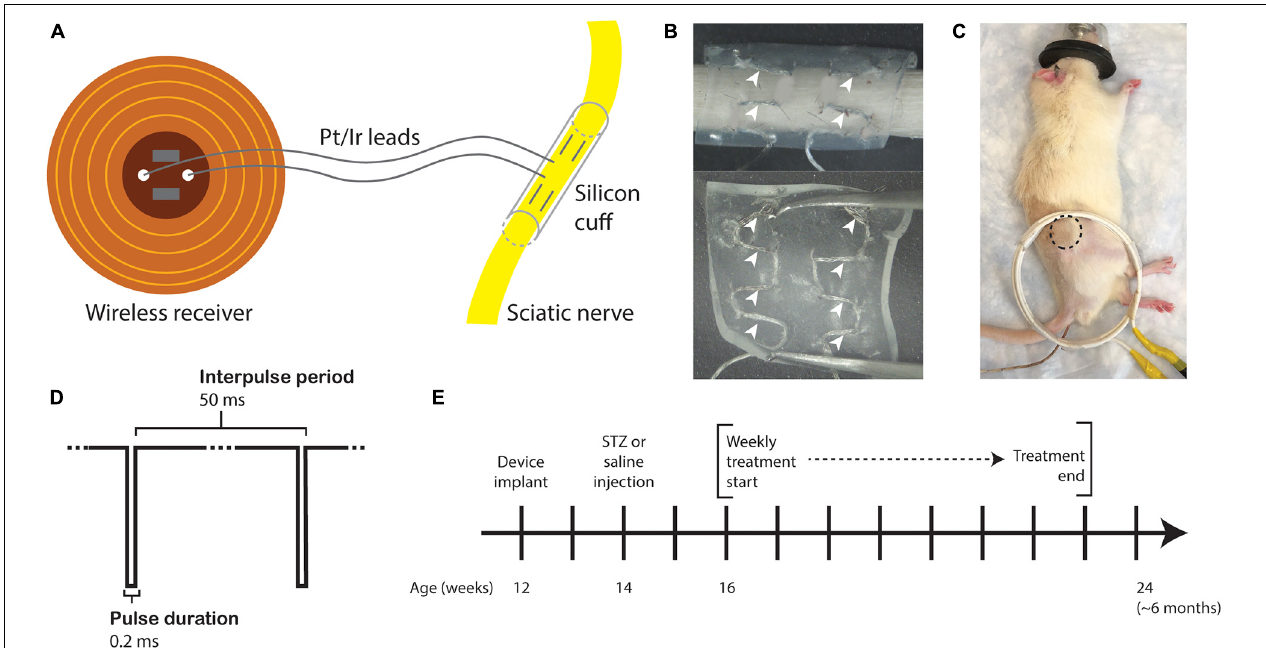
FIGURE 1 | Study design. (A) Drawing of the sciatic nerve cuff stimulator. (B) Outer surface (top) and inner surface (bottom) of the silicone cuff threaded with Pt/Ir electrode leads. White arrowheads indicate horizontally threaded regions in which the electrode wire is exposed to the nerve. (C) Rat under anesthesia for eStim treatment with location of implanted receiver indicated (dotted circle) with external power-transmitting coil (white coil). A rectal probe was inserted for thermal monitoring (wire under tail). (D) Stimulus waveform. (E) Experimental